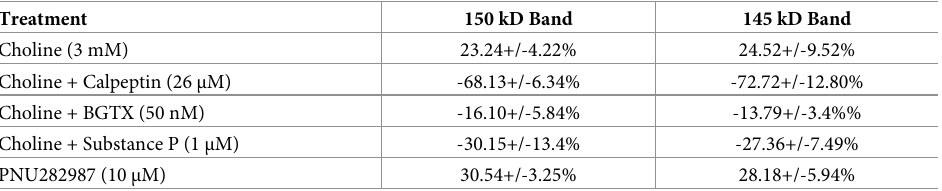
Table 1. Band density analysis of α IIspectrin breakdown based on percent change from the vehicle treated control.